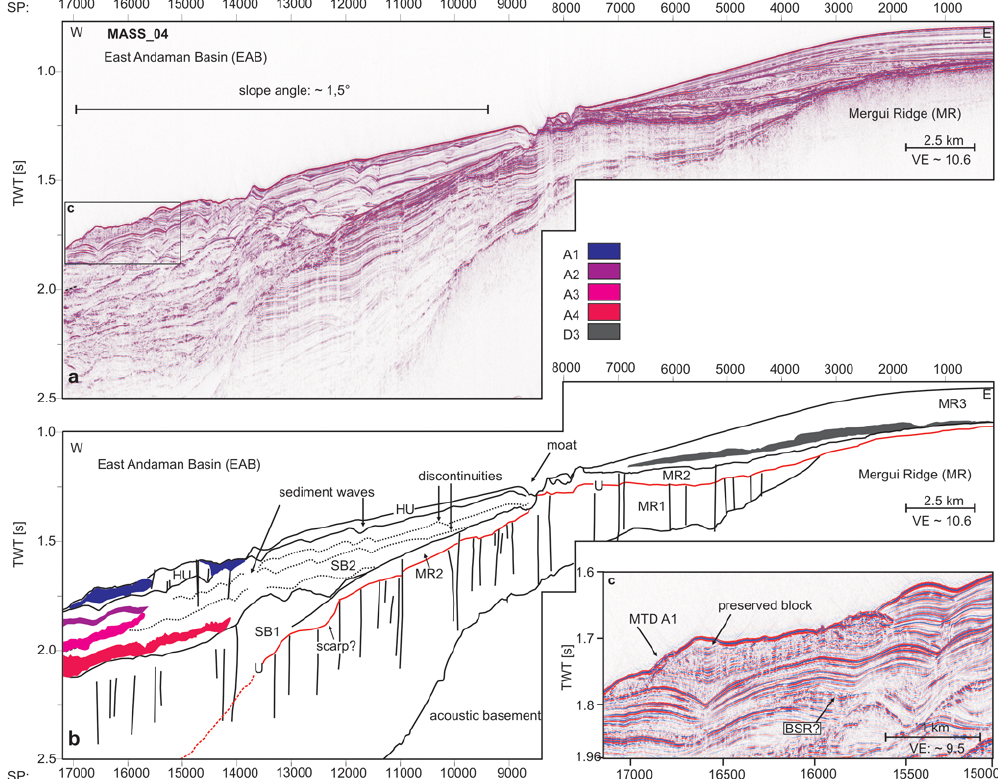
Fig. 4. (a) Seismic profile MASS 04 across the basin–ridge transition Mergui Ridge-East Andaman Basin in the southern working area. (b) Interpretation of the seismic profile showing the seismic units of Mergui Ridge in the east (MR1–MR3) and those of the southern East Andaman Basin area to the west. Faults are marked as black vertical lines. Black lines mark boundaries of seismic units. The black dashed lines mark the positions of possible discontinuities within SB2. The red line denotes the position of the unconformity U . The colored areas mark the position of the MTDs A1–A4. See Figs. 2 and 3 for location of profile. (b) Blowup of the superficial MTD A1, showing blocky structure of the deposit. The label BSR indicates the location of a potential bottom simulating reflector. See text for further explanations. See Figs. 2 and 3 for location of the profile.